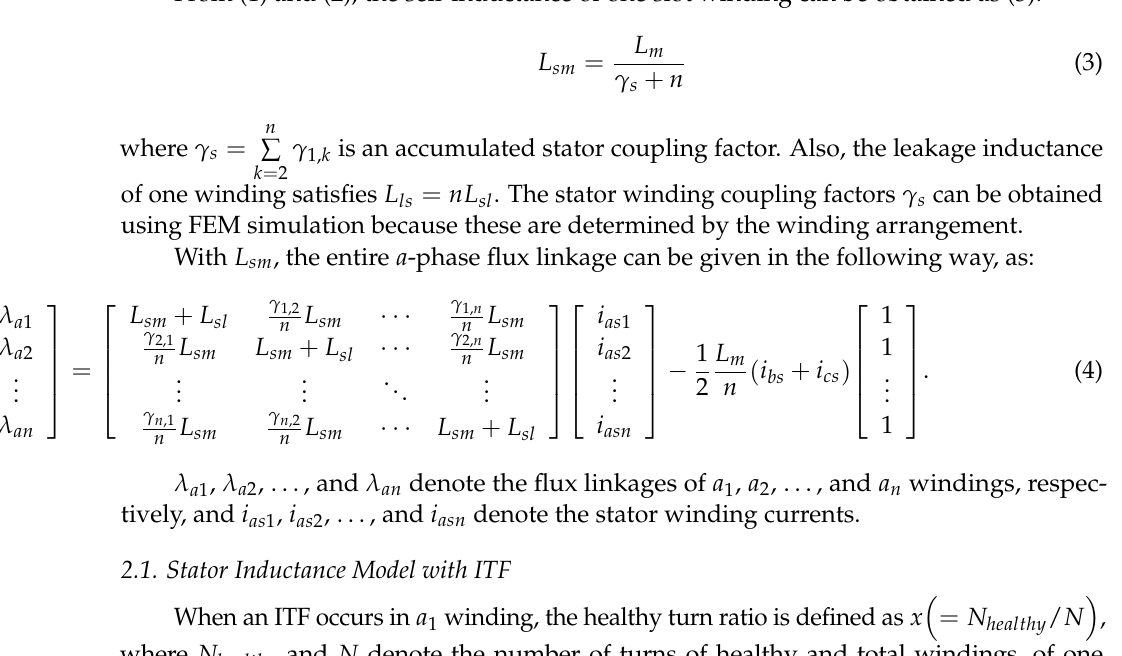
Figure 2. Couple flux linkage of a 1 winding (black lines: Inter-phase, grey lines: inter-winding). From (1) and (2), the self-inductance of one slot winding can be obtained as (3).